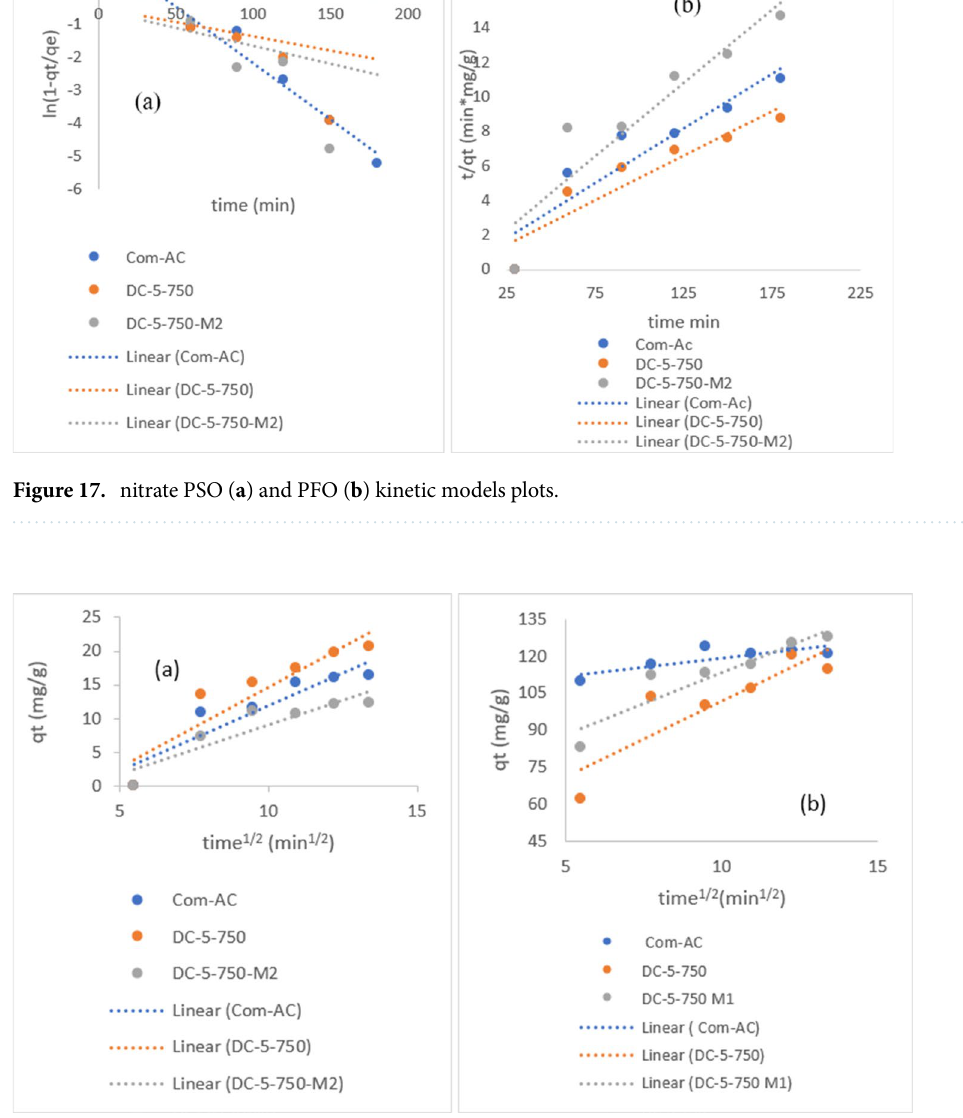
Figure 18. intraparticle model diffusion of nitrate ( a ) and MR ( b )